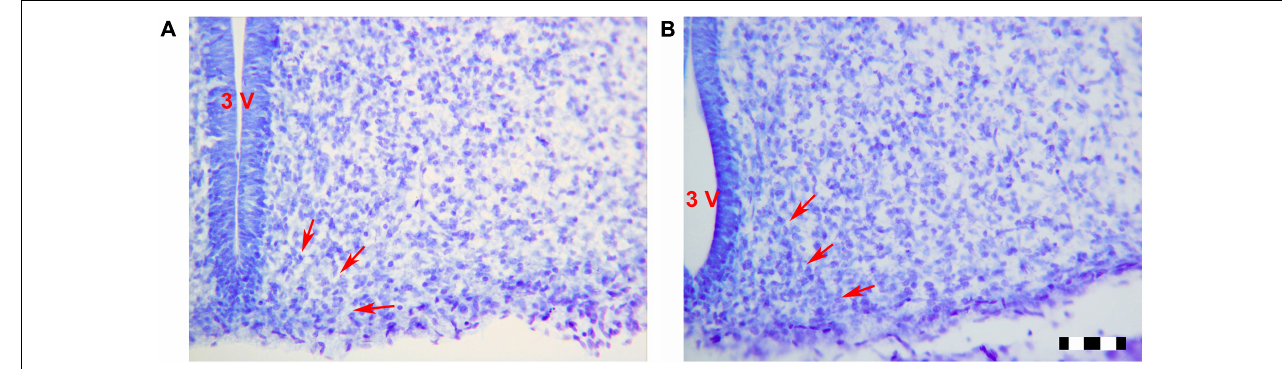
FIGURE 5 | Photomicrographs ( × 25) showing differences between the male groups in posterior ARC. Limits of the ARC are signaling by red arrows. (A) CM; (B) LPCM. CM, control male; LPC, low-protein and low caloric male. Bar = 50 µ